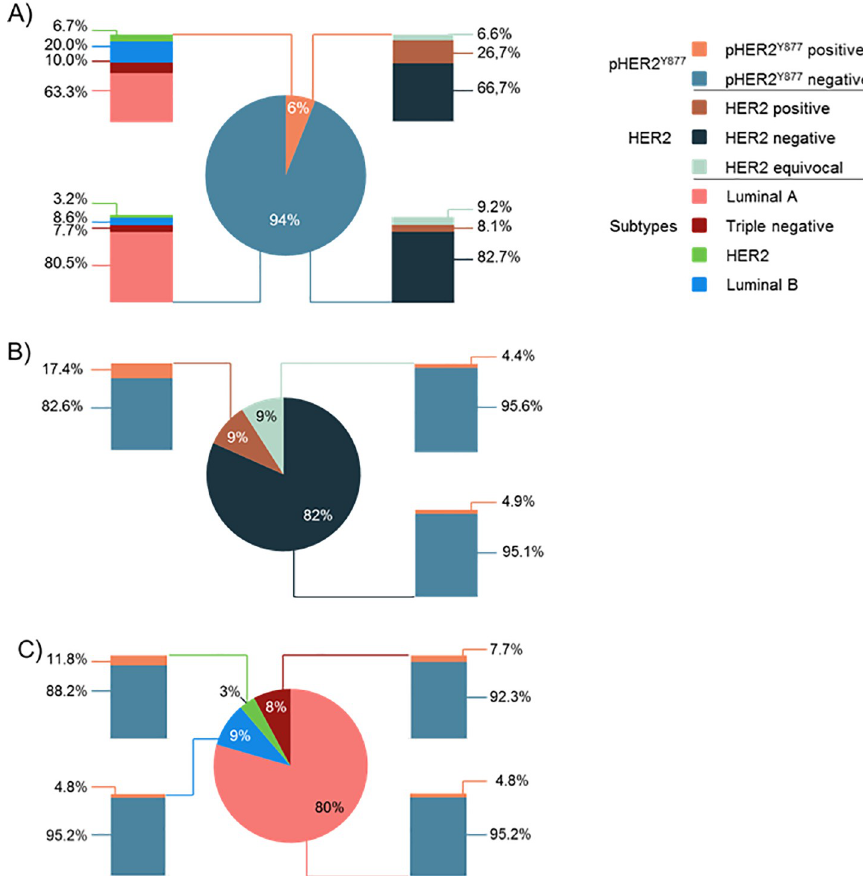
Fig 3. pHER2 Y877 distribution. pHER2 Y877 status was evaluated using the 2013 ASCO/CAP scoring guidelines after staining by IHC with anti-pHER2 Y877 antibody. Score 2+ were considered as positive. HER2 status was evaluated by IHC (HercepTestTM kit) according to the 2013 ASCO/CAP scoring. Molecular subtypes were identified using the ER and PR status evaluates by IHC and the global HER2 status (IHC + FISH status). A) pHER2 Y877 prevalence in the cohort. B) pHER2 Y877 distribution according to HER2 status (defined by IHC). C) pHER2 Y877 distribution according to molecular subtypes.